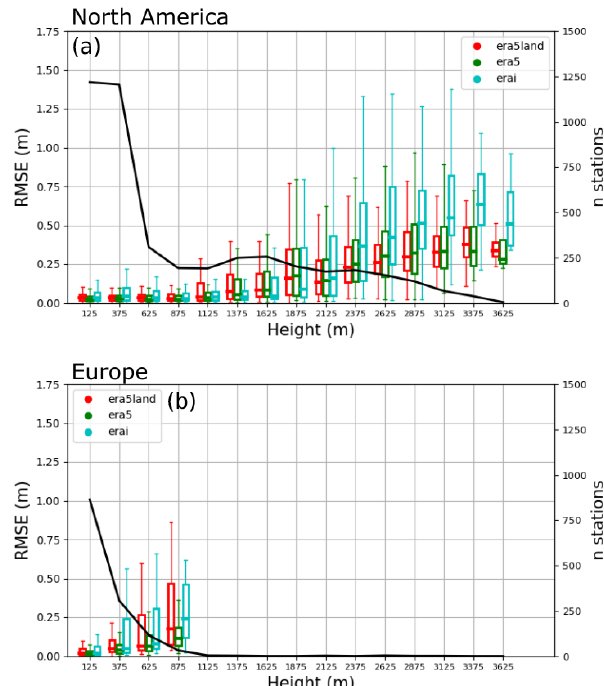
Figure 10. Box plot of the snow depth RMSE distribution as func- tion of the site altitude, for North America (30–80 ◦ N, 60–160 ◦ W, a ) and Europe (25–80 ◦ N, 10 ◦ W–40 ◦ E, b ), for ERA5-Land (red), ERA5 (green), and ERA-Interim (cyan). Boxes extend between the lower (25%) and upper quartiles (75%), and the horizontal lines within each box represent the median value of the distribution. The black line represents the number of stations grouped at each